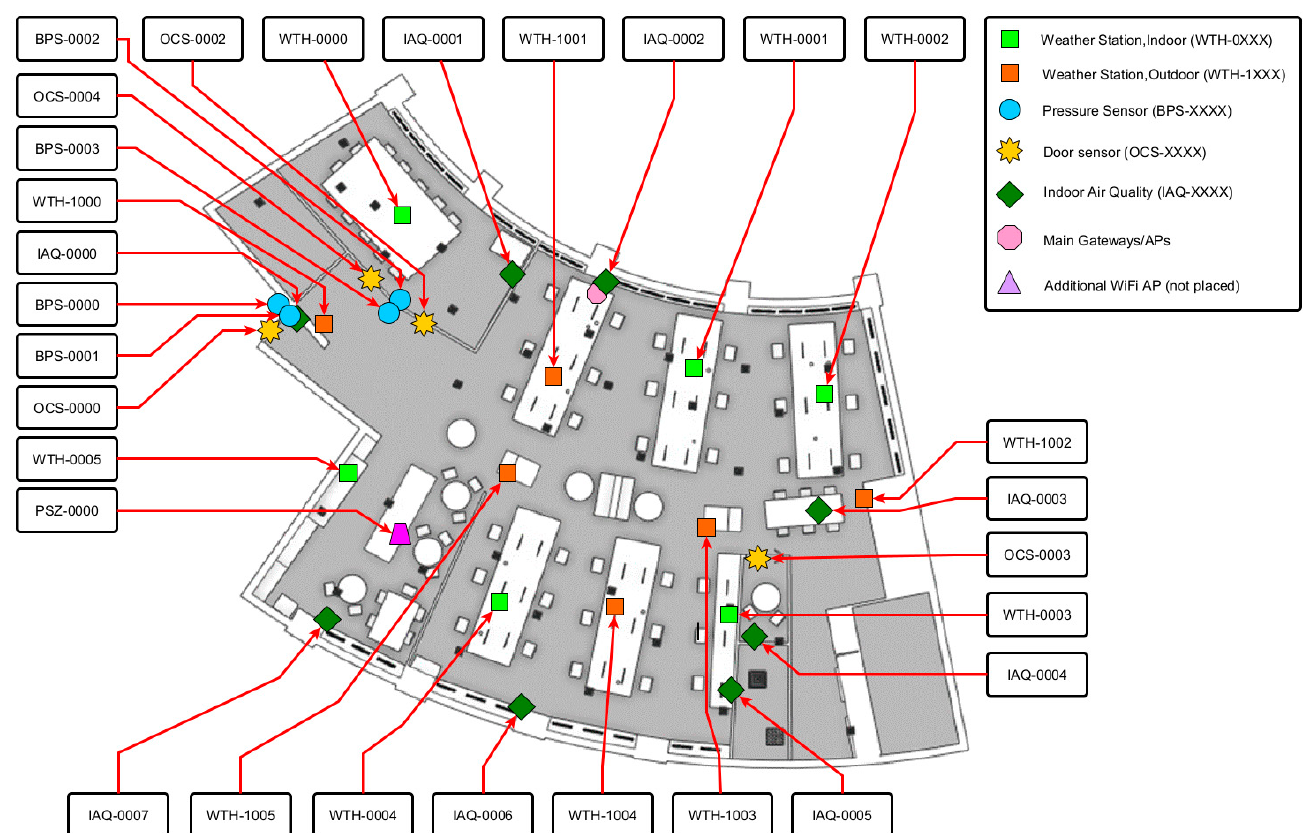
Figure 4. An example of an open plan office with sensor locations.